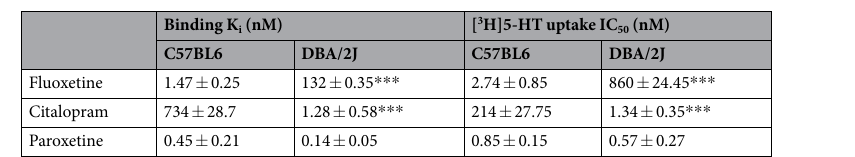
Table 1. The specific parameters in binding and uptake assays. Fluoxetine, citalopram and paroxetine compete for 5-HT transporter binding (specific [ 3 H]paroxetine binding) and 10 nM [ 3 H]5-HT reuptake into hippocampal synaptosomes in the two mouse strains. The IC 50 value was generated from each of these curves. Each data point depicted represents the mean ± S.E.M of 3–4 mice. *** p < 0.001, Student’s t